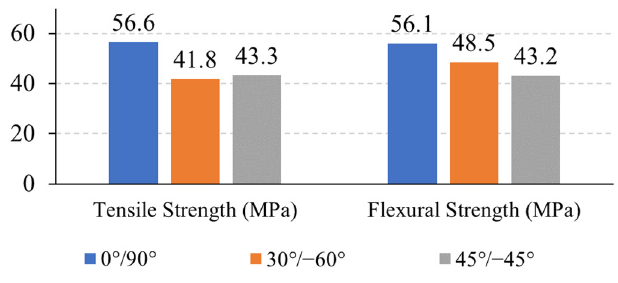
Figure 11. PEEK strength sensitivity to various raster angles (in degrees).